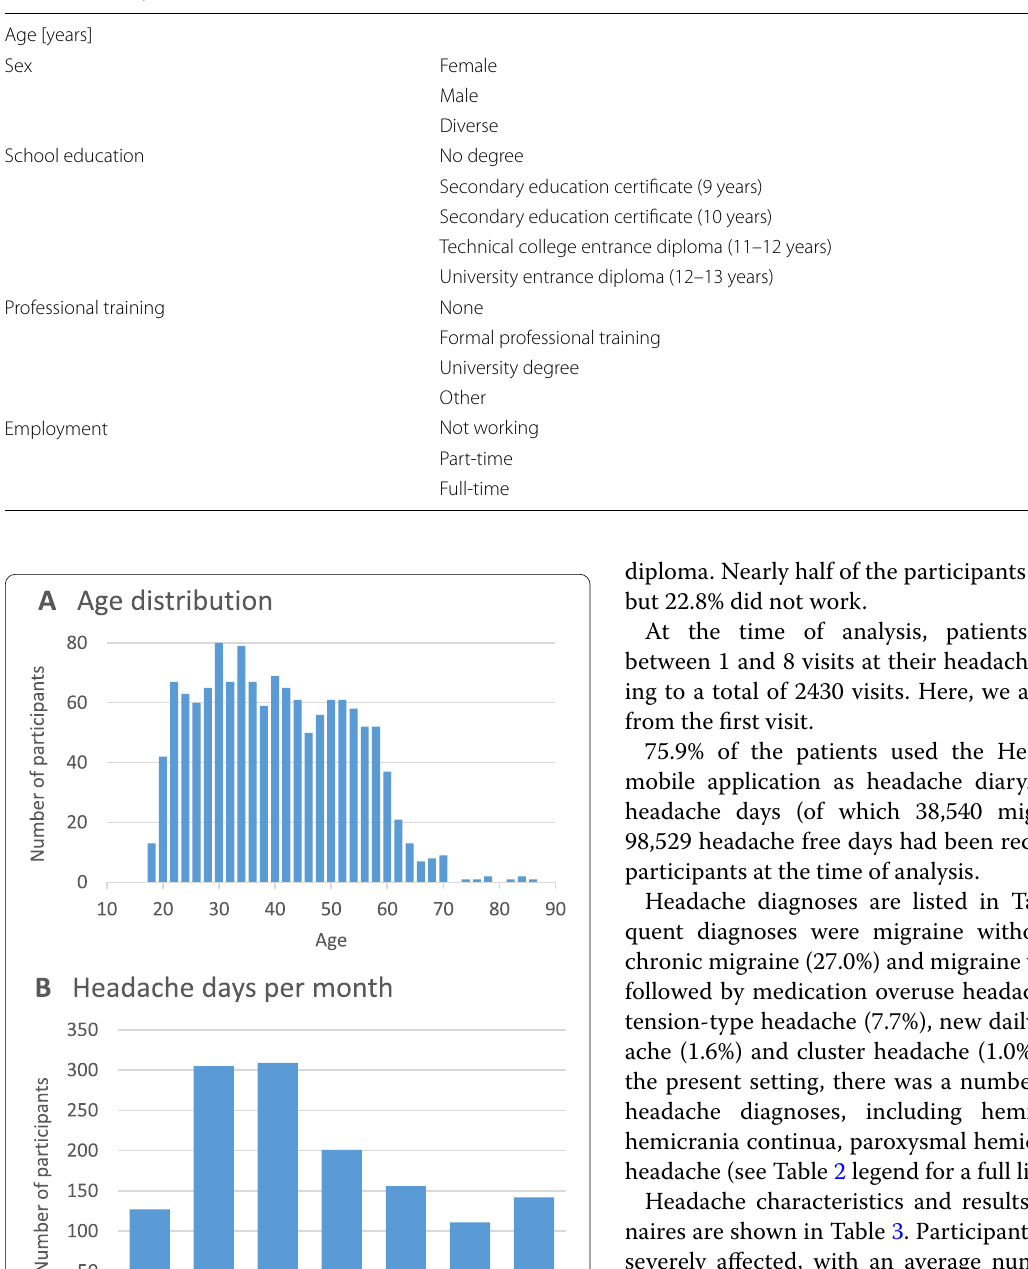
Table 1 Participant characteristics ( n